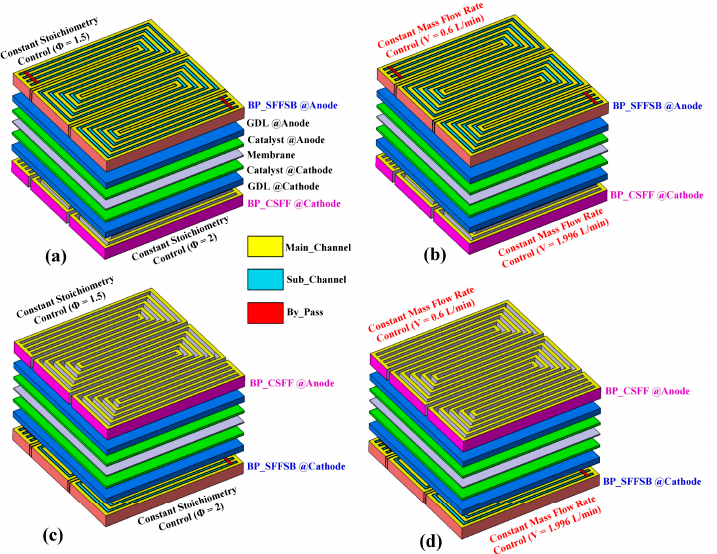
Figure 1. Schematics of the computational domains for the polymer electrolyte membrane fuel cell (PEMFC) system simulations and experiments: ( a ) configuration I, in which a serpentine flow-field with sub-channel and by-pass (SFFSB) and a conventional serpentine flow-field (CSFF) were used at the anode and cathode, respectively, and the constant stoichiometry ratios of supply gases were controlled; ( b ) configuration II, in which an SFFSB and a CSFF were used at the anode and cathode, respectively, and the constant mass flow rates were controlled; ( c ) Configuration III in which a CSFF and an SFFSB were used at the anode and cathode, respectively, and the constant stoichiometry ratios of supply gases were controlled; and ( d ) configuration IV, in which a CSFF and an SFFSB were used at the anode and cathode, respectively, and the constant mass flow rates were